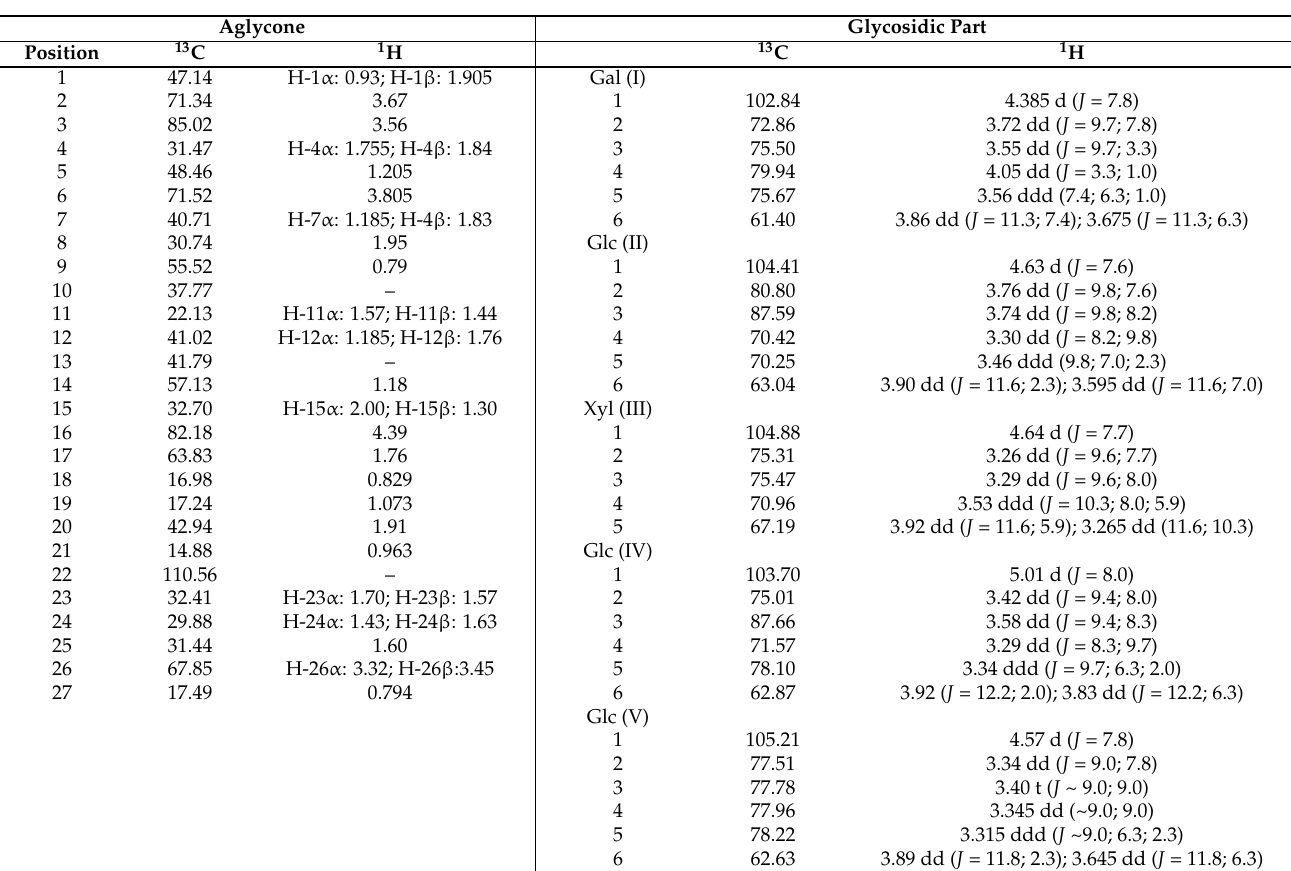
Table 3. 13 C and 1 H NMR data of alliporin ( 3 ) in CD 3